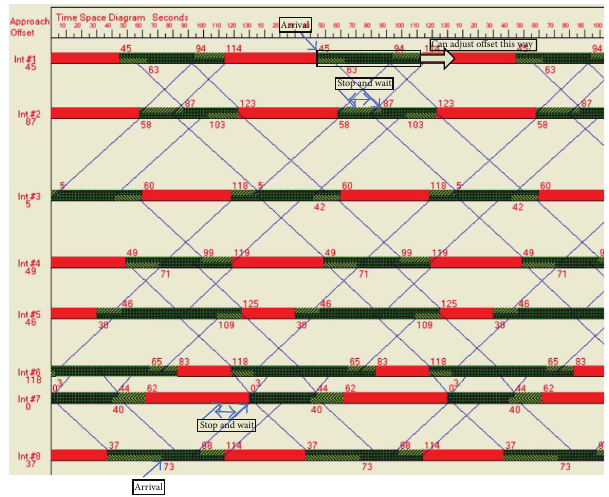
Figure 6: TSD of signal timing plan with Messer’s algorithm.